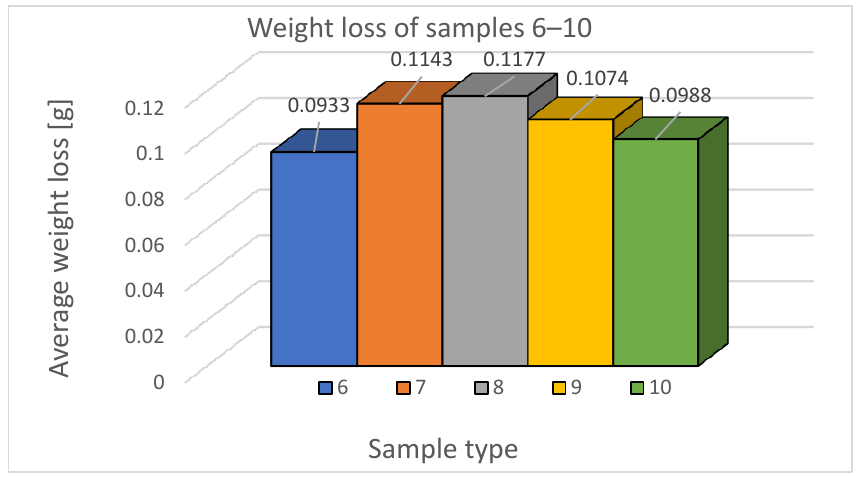
Figure 8. Weight differences among similar Samples 6 – 10 (g).